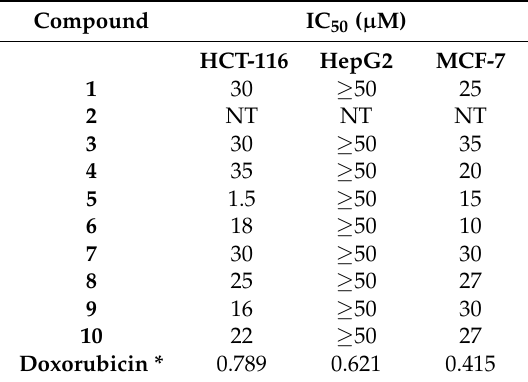
Table 4. Cytotoxic activities of compounds 1 – 10